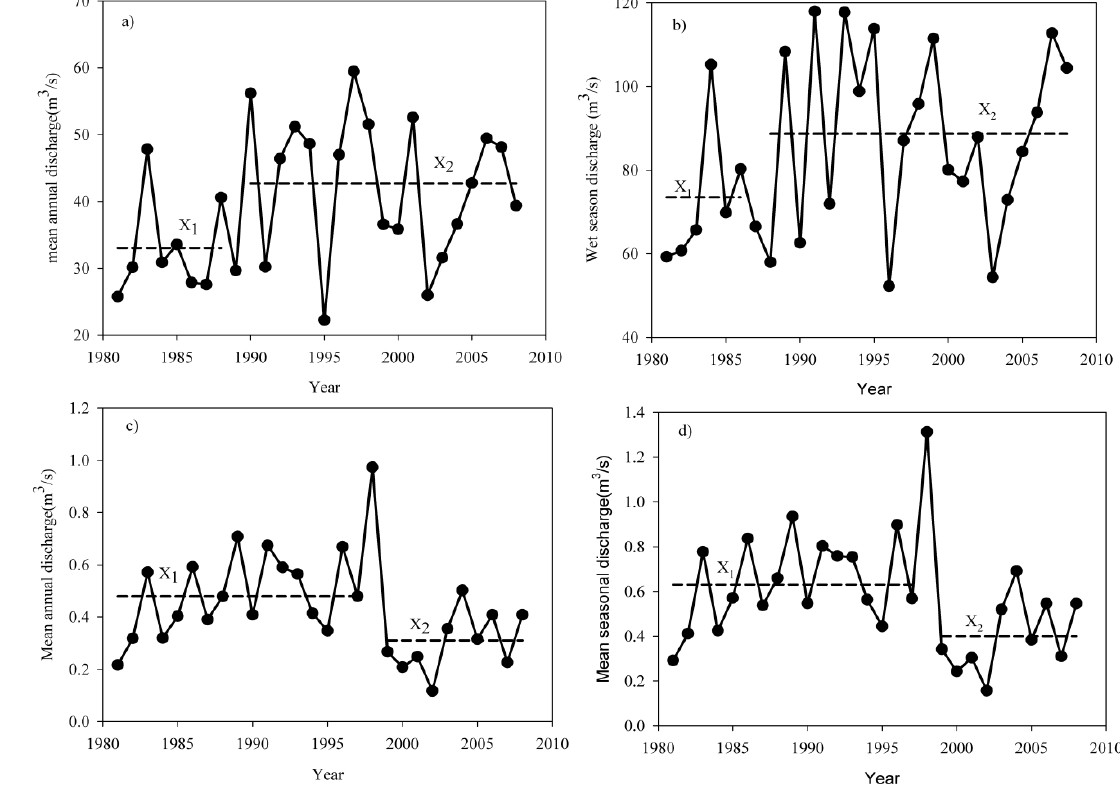
Figure 9. Mean annual and seasonal streamflow time series and change points: ( a , b ) Mean annual and wet season discharge at Assendabo station, ( c , d ) Mean annual and wet season discharge at Sekoru station. The dashed lines represented by X 1 and X 2 are the mean of the time series before and after the change point, respectively.